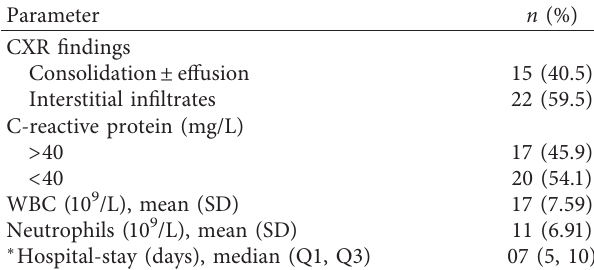
Table 1: Laboratory and radiological parameters of